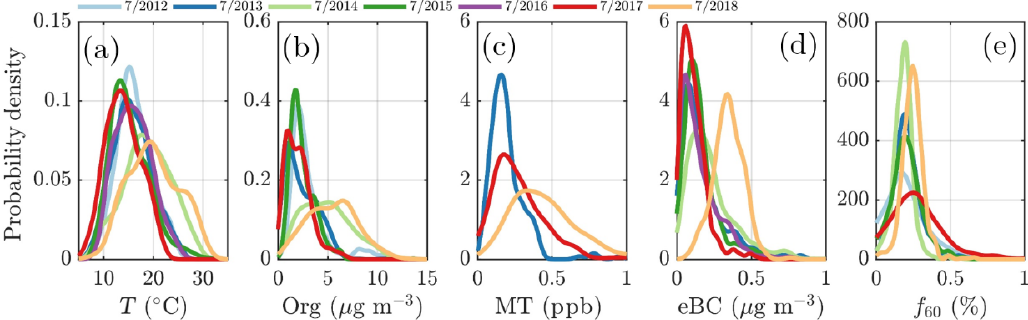
Figure 6. Nonparametric probability densities (kernel distributions) of temperature (a) , organic aerosol (b) , monoterpenes (c) , equivalent black carbon (d) concentrations, and the fraction of the ACSM organic signal made up by levoglucosan-like species ( f 60 ; e ) during individual months of July across the measurement period (2012–2018). The data availability for eBC was 1 week in July 2018. The x axes represent the T , Org, MT, and eBC values recorded, respectively, and the y axes the nonparametric probability densities. Briefly, the kernel distributions are similar to smoothed histograms of the measurement data. This visualization was chosen to avoid assumptions of the nature of distribution that might hide important features of the measurement data if presented with normal distributions, for